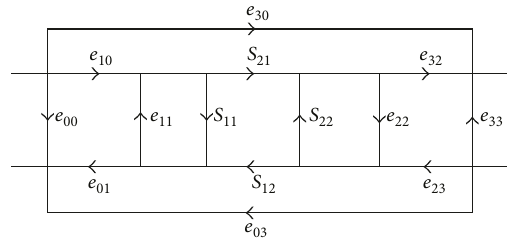
Figure 1: The ten-term error model of a two-port